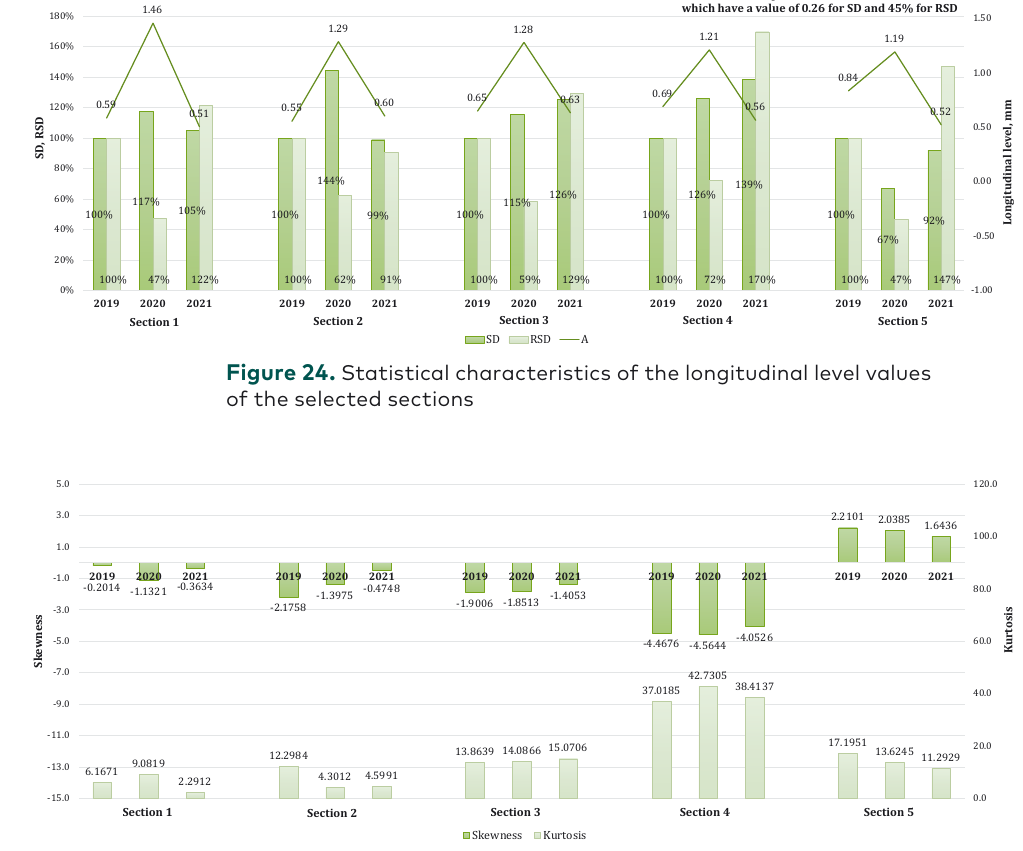
Figure 25. The change of the longitudinal level parameter values of the selected sections over time, considering the skewness and kurtosis